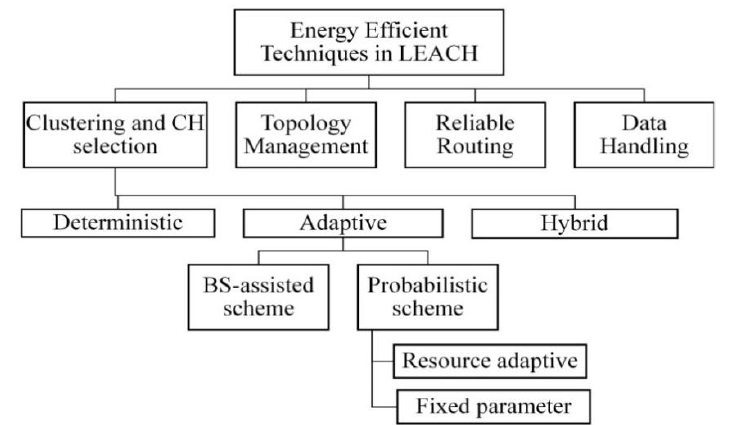
Figure 6. Taxonomy of clustering strategies